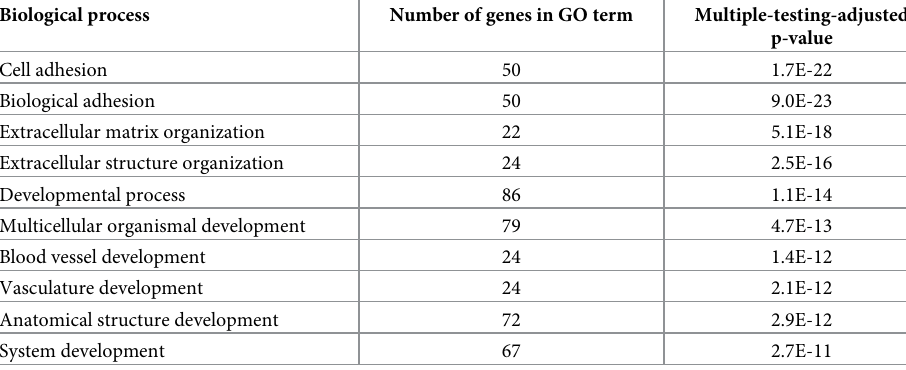
Table 4. Significant GO terms (GOTERM_BP_ALL) that are associated with the top 200 genes mostly correlated with GPC6 across all 33 TCGA